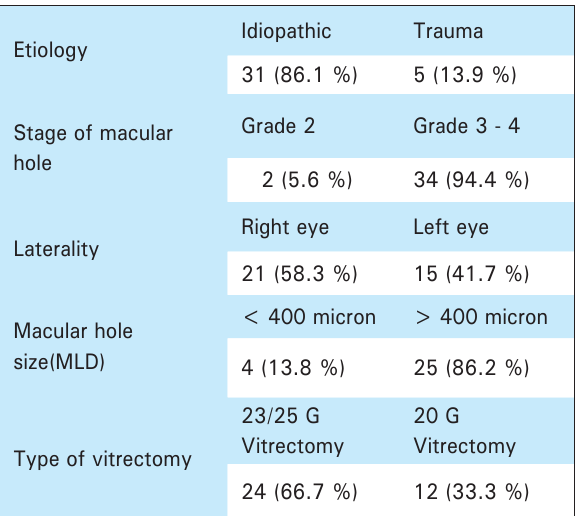
Table 3. Characteristics of the macular hole and types of vitrectomy